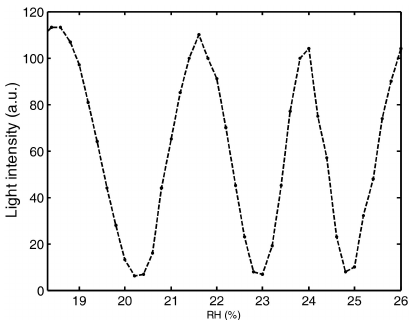
Figure 1. Light intensity as a function of Relative Humidity when a thin layer of gelatin was used as the humidity